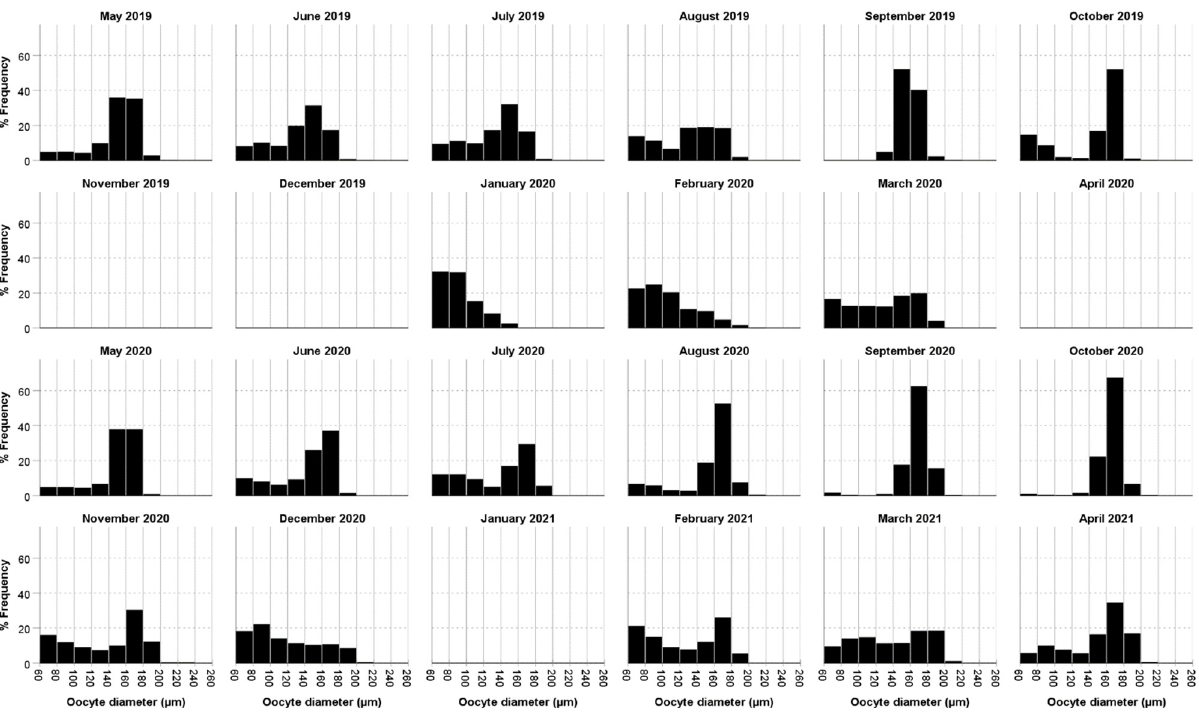
Figure 3. Monthly distribution of oocyte sizes of Diopatra neapolitana from Redondela (NW Spain). No samples were caught in the months of December 2019, May 2020 and January 2021.